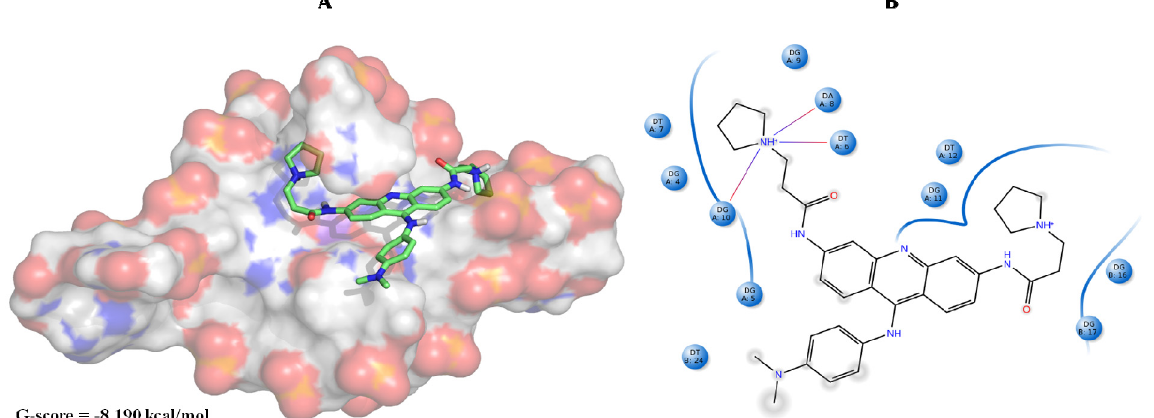
Figure 6. ( A ) BRACO-19 best pose against the 3CE5 PDB model obtained by Glide HTVS docking method. ( B ) BRACO-19 best pose interaction diagram 2D representation. The red lines and the grey spheres indicate, respectively, the salt bridge contacts and the solvent exposure areas.